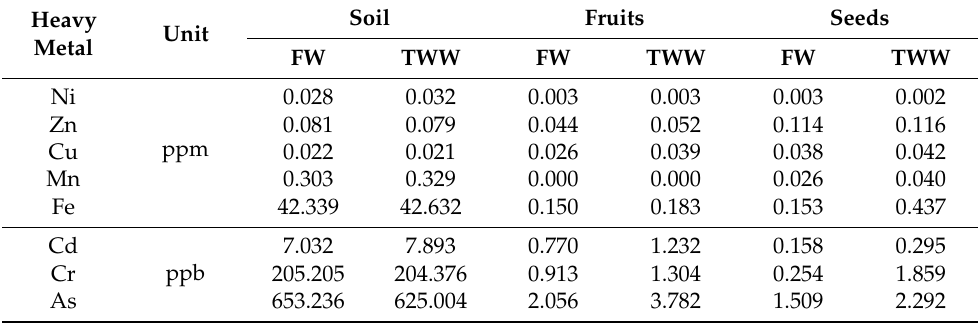
Table 3. Effect of using TWW and FW on heavy metal accumulation in soil, fruits and seeds. Heavy